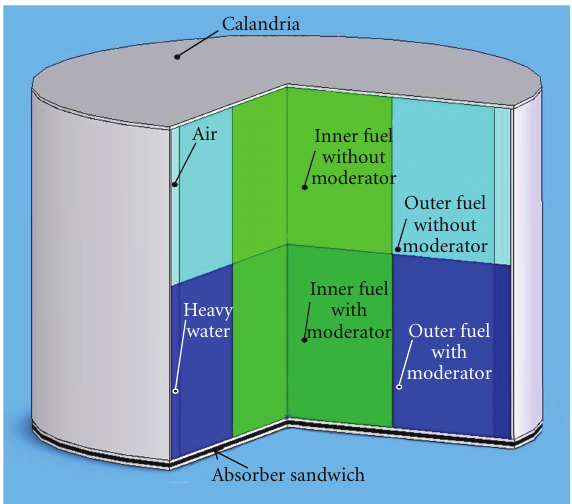
Figure 2: DCA Core